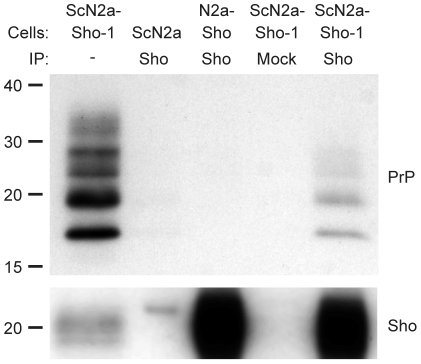
Copurification of Sho and misfolded PrP from ScN2a-Sho-1 cell lysates.Sho copurified with PrP molecules in lysates prepared from ScN2a-Sho-1 cells, but not with PrPC in N2a-Sho cells, as demonstrated by coimmunoprecipitation analyses. Nonspecific binding of misfolded PrP to the immunoprecipitation matrix was assessed by performing immunoprecipitations on ScN2a cells that do not express Sho and on ScN2a-Sho-1 cells in the absence of antibody (Mock). Samples were not treated with PK prior to Western blotting. Sho and PrP were probed using antibodies 06rSH-1 and HuM-D18, respectively. Molecular masses based on the migration of protein standards are shown in kilodaltons.